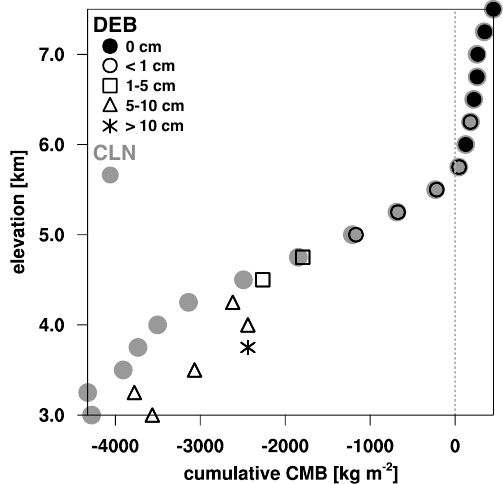
Figure 5. The cumulative vertical balance profile, averaged in 250m elevation bins between 3000 and 7500ma . s . l . , over all glacier pixels and from 1 July to 15 September 2004. Solid gray circle markers denote results from the CLN simulation, while those from DEB are plotted with black markers. The shape of the black marker indicates the range of the mean debris thickness in that ele- vational band.